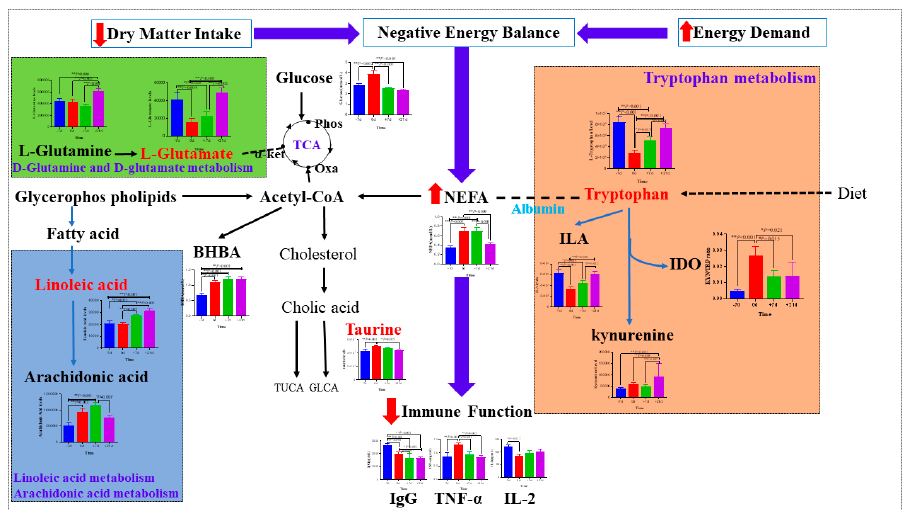
Figure 10. Metabolic pathways involving major metabolites with different plasma concentrations on − 7, 0, +7, and +21 d relative to calving. (+) indicates increased level and ( − ) indicates decreased level. TCA—tricarboxylic acid; IDO—indoleamine 2,3-dioxygenase; TUCA—taurocholic acid; GLCA—glycocholic acid; Phos—phosphenol pyruvic acid; α -KET— α -ketoglutaric acid; Oxa—oxaloacetate.